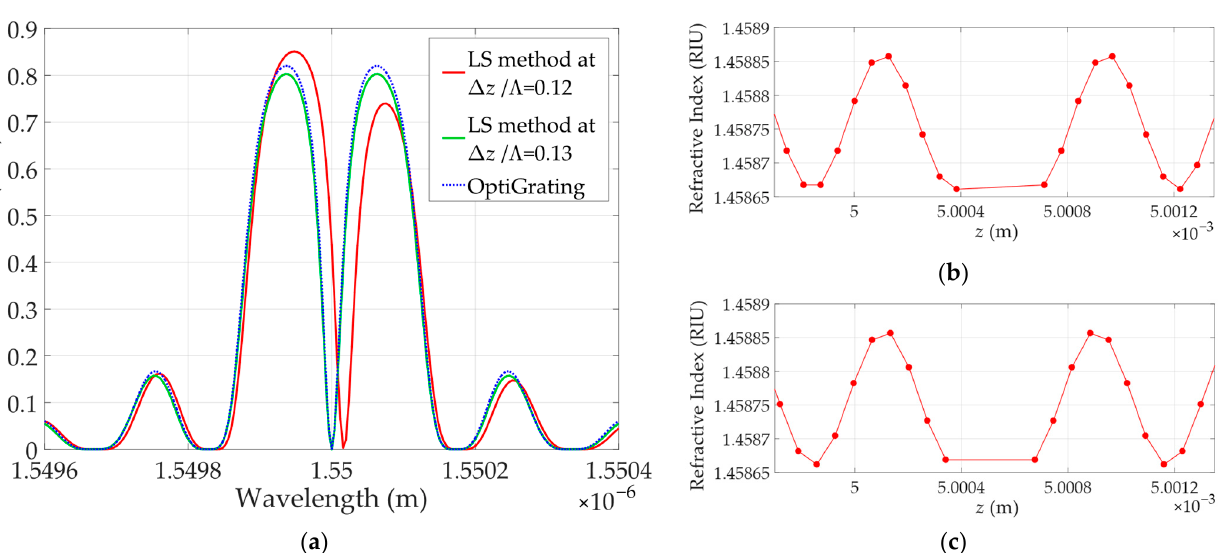
Figure 9. Values of the root-mean-square deviation (RMSD) of the π -phase-shifted FBG spectrum modeled using the LS method (blue dots) depending on the partition interval Δ z .